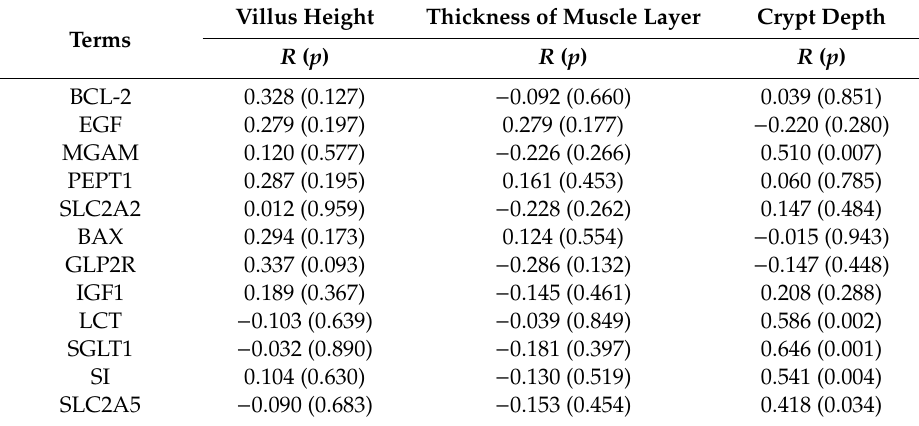
Table 5. Correlation analysis of genes and phenotypes in the duodena of newborn lambs supplemented with folic acid during maternal gestation.